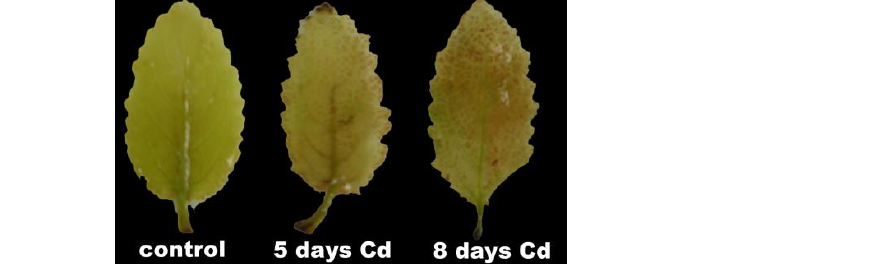
Figure 12. Histochemically detected H 2 O 2 in leaves of Salvia sclarea , control, and 5- and 8-days Cd- treated plants. Hydrogen peroxide is forming brown precipitates with 3,3′-diaminobenzidine (DAB).